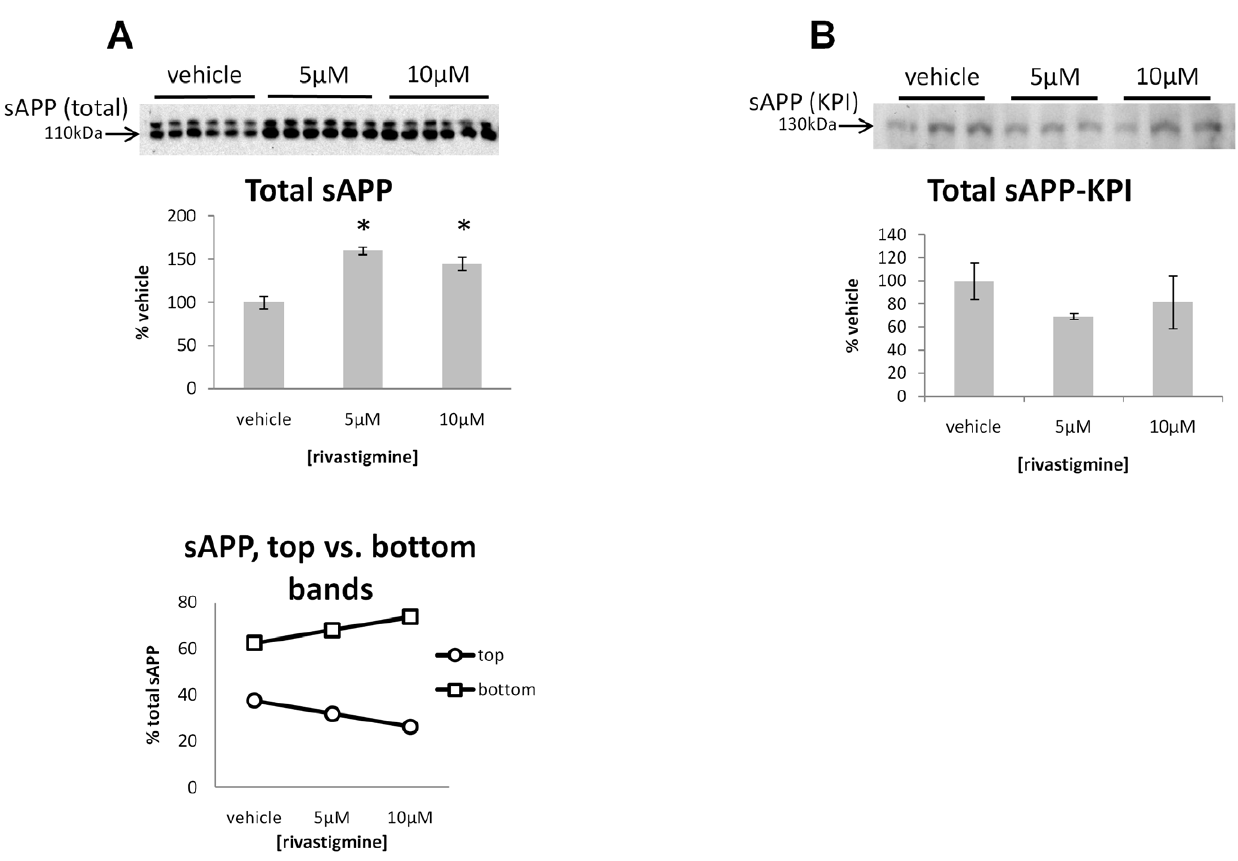
Figure 4. Rivastigmine increases the proportion of neuron-associated sAPP isoform to total secreted amyloid precursor protein (sAPP). A : Relative levels of total sAPP were measured by Western blot using the monoclonal 22C11 antibody. Densitometric quantification of the blots indicates that total sAPP is increased significantly at both rivastigmine concentrations tested (both p , 0.05). The intensity of each band relative to the total sAPP was calculated and the top and bottom bands show diverging patterns, with the top band decreasing with rivastigmine treatment, and the bottom band increasing with rivastigmine treatment relative to total sAPP. B : Levels of the longer KPI-containing sAPP isoform were determined by Western blot using a KPI-specific antibody. A single band was detected in the media samples of these cells, and the molecular weight of this band coincides with the higher molecular weight band detected with the 22C11 antibody. Thus, the distinguishing characteristic between the top and bottom bands observed with 22C11 are differences in splicing. Levels of KPI containing APP are not altered by rivastigmine